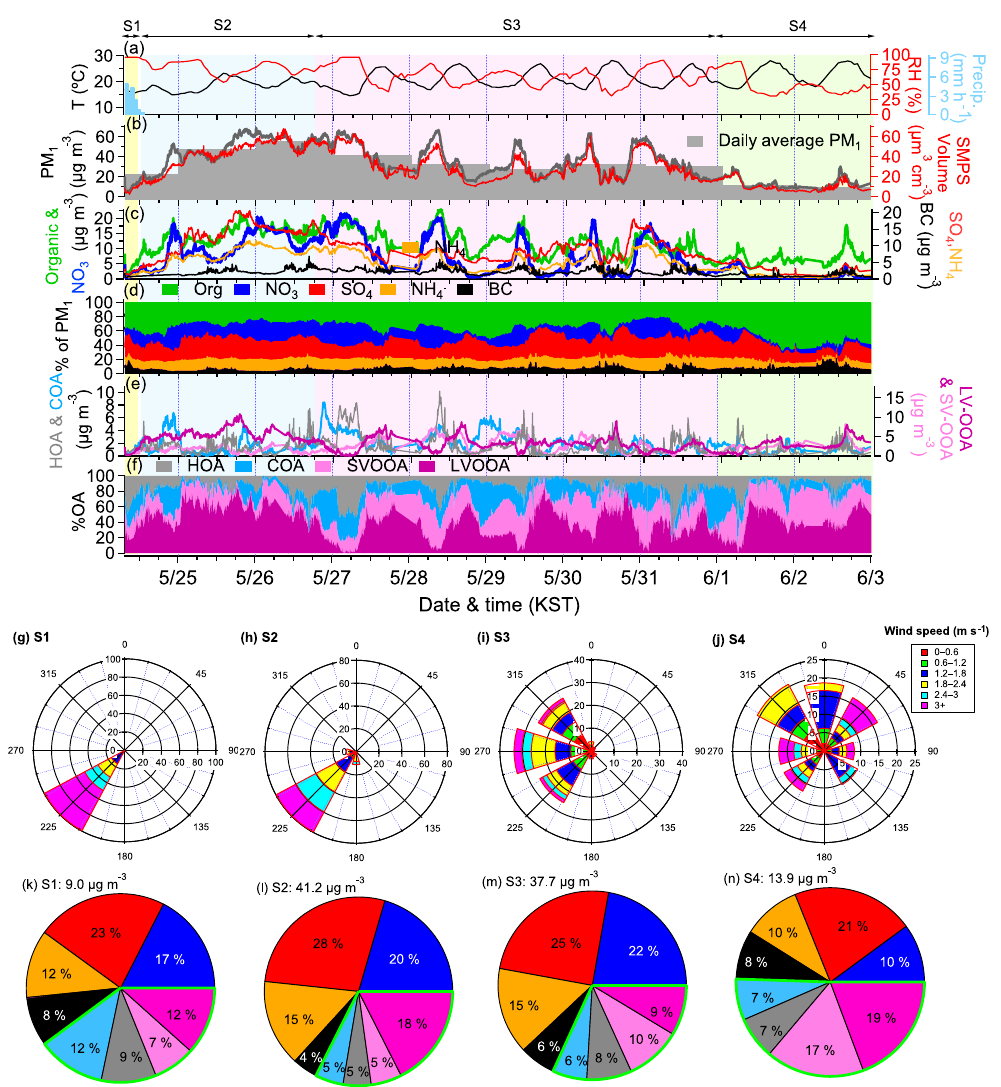
Figure 11. (a) Time series of ambient air temperature ( T ), relative humidity (RH), and precipitation (Precip.); (b) time series of total particulate matter (PM 1 ), scanning mobility particle sizer (SMPS) volume concentrations, and the 24h averaged PM 1 + BC with bars; (c) time series of the organic (Org.), nitrate (NO − fractional contribution of organic aerosols (Org.), nitrate (NO − (e) time series of each factor derived from the positive matrix factorization (PMF) analysis; (f) time series of mass fractional contribution of OA factors to OA; (g–j) wind rose plots, colored by wind speed; and (k–n) fractional contributions of each species to the total PM 1 (non-refractory-PM 1 plus BC) mass for each stage in haze